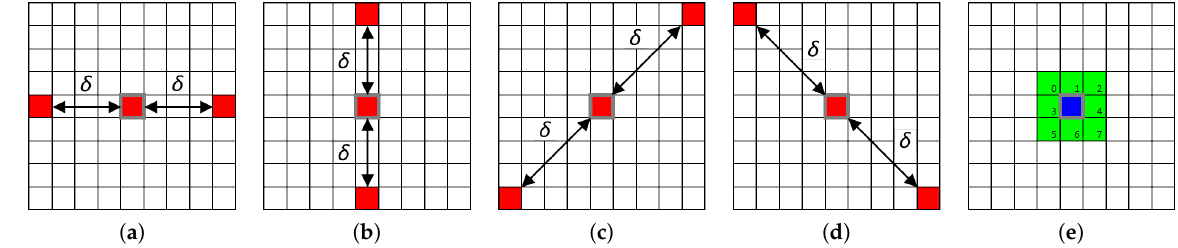
Figure 3. Possible parameter settings of the RSCCM descriptor in the RGB color space: ( a ) 2-neighborhood and 0 ◦ direction with the ( R , R ) component pair; ( b ) 2-neighborhood and 90 ◦ direction with the ( R , R ) component pair; ( c ) 2-neighborhood and 45 ◦ direction with the ( R , R ) com- ponent pair; ( d ) 2-neighborhood and 135 ◦ direction with the ( R , R ) component pair; and ( e ) ( 3 × 3 ) 8-neighborhood with the ( B , G ) component